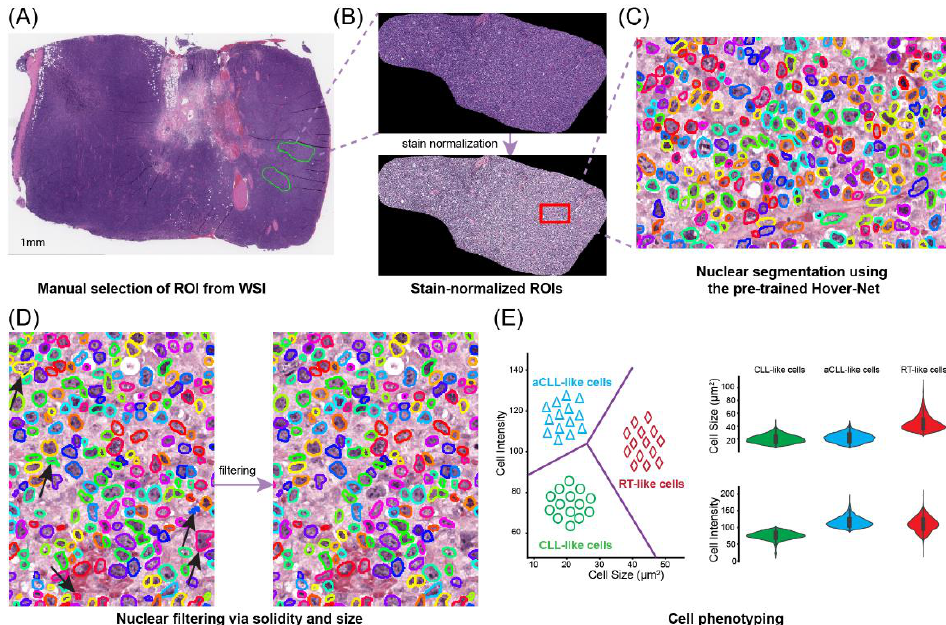
Figure 1. The pipeline cellular feature engineering with unsupervised clustering for diagnosis of chronic lymphocytic leukemia (CLL) progression. ( A ) Manual selection of diagnostically informative ROIs with high tissue quality. ( B ) Stain normalization on ROIs with the reference-free Vahadane algorithm to mitigate undesirable color variations. ( C ) Nuclear segmentation on selected ROIs using the Hover-Net model pre-trained on the PanNuke dataset. ( D ) Filtering segmented nuclei with irregular shape and abnormal size via solidity and size properties. ( E ) Clustering cells into three phenotypes (CLL-like, aCLL-like, and RT-like) with an unsupervised learning method. Differences in cell size and intensity are manifested among these three cell phenotypes.